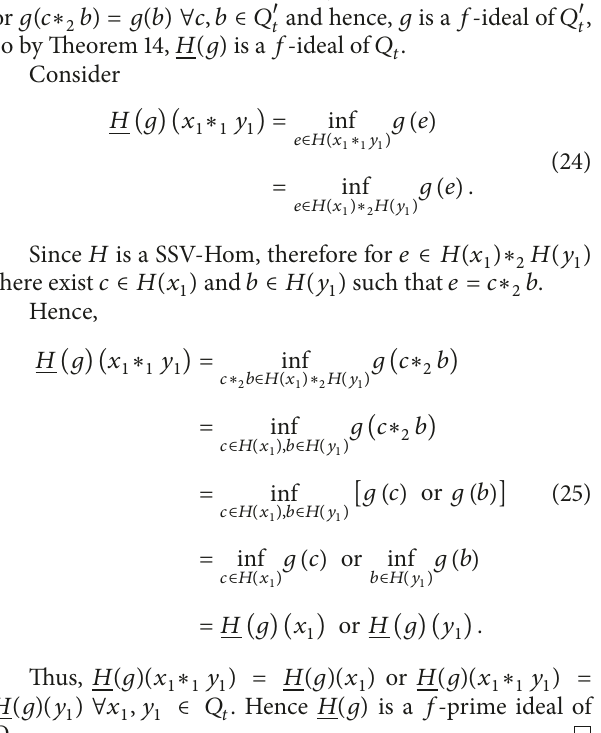
Figure 2: Illustration of 𝑄 󸀠 𝑡 .